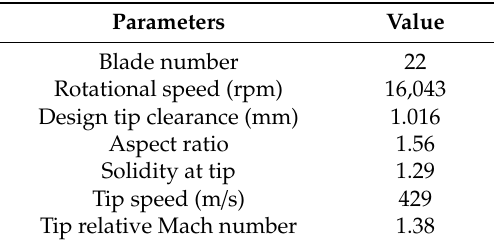
Table 1. Main design parameters of Rotor67.